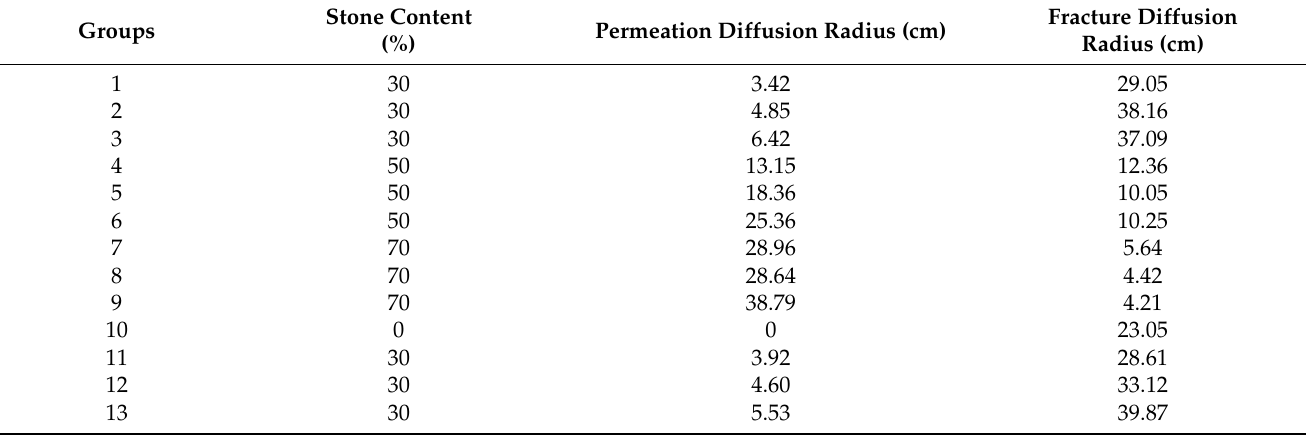
Table 4. Indoor grouting diffusion test